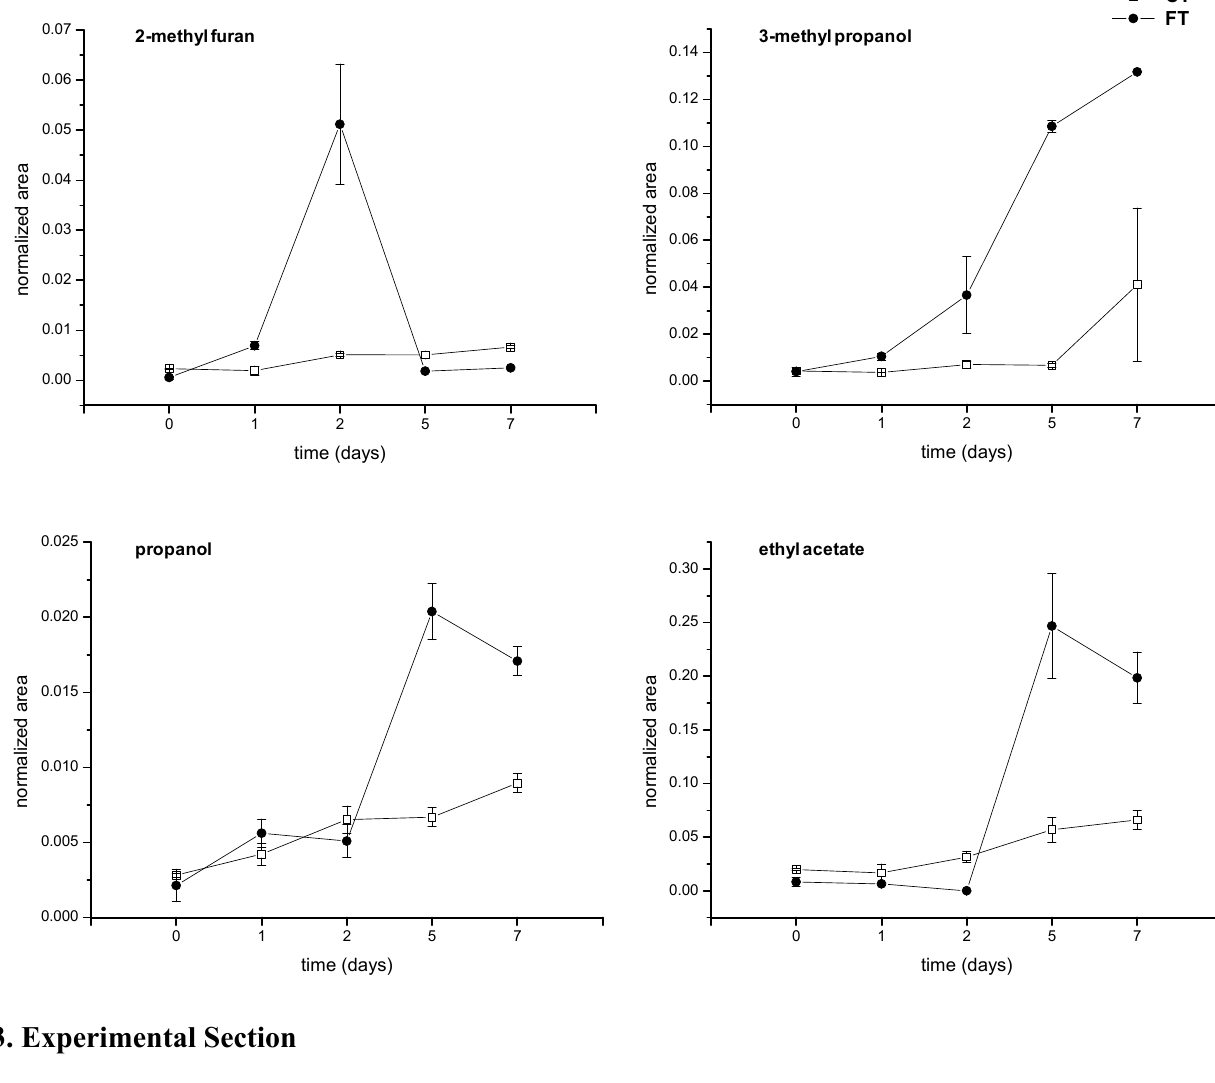
Figure 5. Time course analysis of metabolites detected at different days of analysis in F. poae -infected samples (FT) and controls (CT). The data are averages of triplicate analysis (±standard